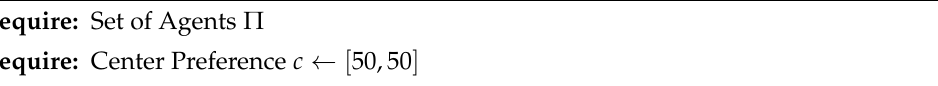
Algorithm 2 Policy